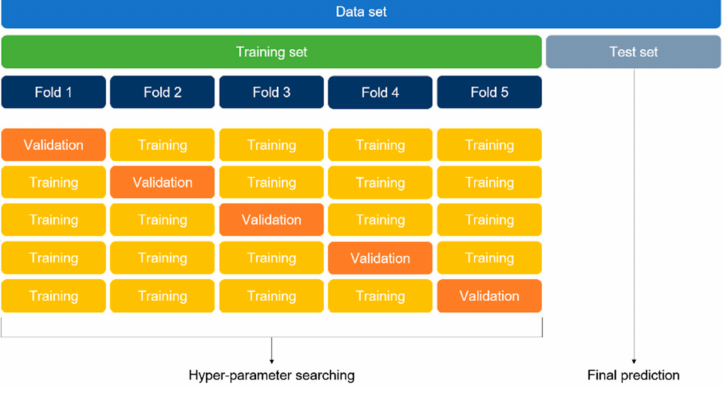
Figure 4. Five-fold cross-validation